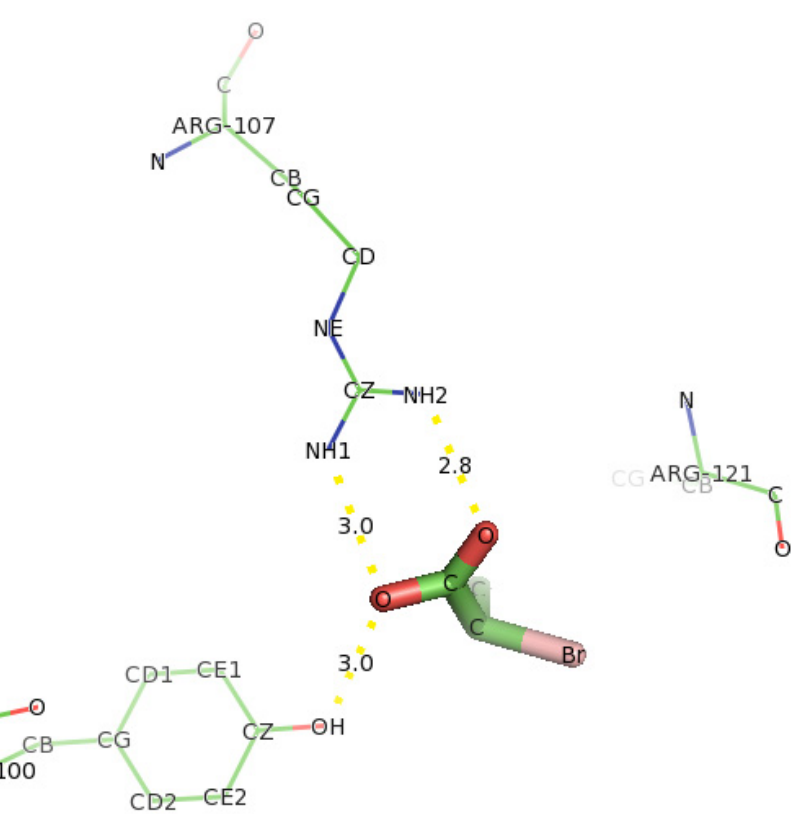
Figure 18. The interaction of D -2BP with catalytic amino acid residues of DehD enzyme. Hydrogen bond distances are in